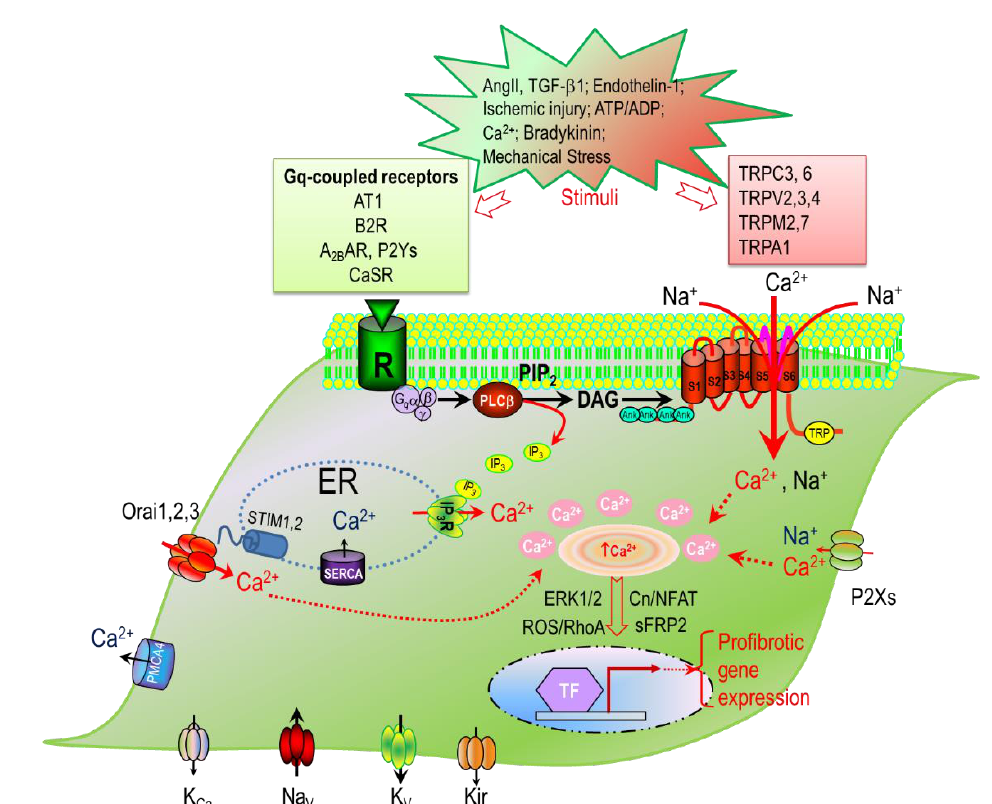
Figure 2. Ca 2+ signaling mechanisms in cardiac fibroblasts and myofibroblasts. Intracellular Ca 2+ levels are finely controlled by: (1) Ca 2+ entry through Ca 2+ -permeable channels in the plasma membrane, including TRP channels, P2X receptors, and Orai/STIM channels; (2) Ca 2+ release via IP 3 Rs in the ER; and (3) Ca 2+ extrusion pumps, including SERCA in the ER and PMCA4 in the plasma membrane. Pathophysiological stimuli can activate Gq-coupled receptors to induce Ca 2+ release, which is secondarily followed by Ca 2+ entry. Receptor stimulation can also directly activate Ca 2+ -permeable (TRP) channels in the plasma membrane. Other ion channels, including voltage-gated K + (K v ) channels, Kir channels, Ca 2+ -activated potassium (K Ca ) channels, and Na V channels, may influence the resting membrane potential or depolarization to indirectly influence Ca 2+ entry in fibroblasts and myofibroblasts. An increase in intracellular Ca 2+ activates the calcineurin/NFAT (CN/NFAT), ERK1/2, ROS/RhoA, and sFRP2 pathways to promote profibrotic gene expression.